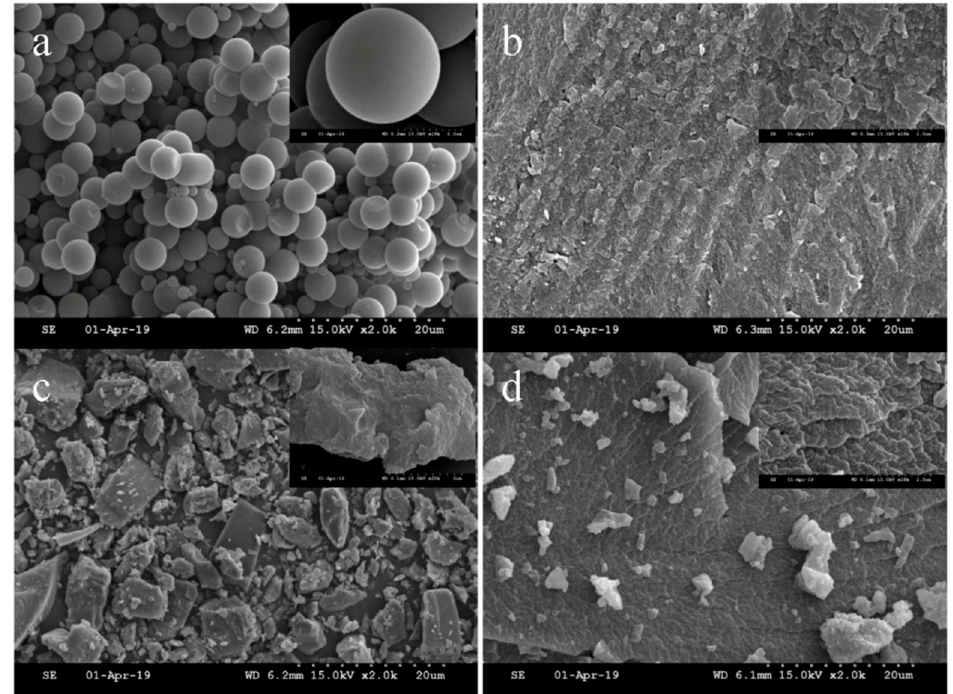
Figure 4. Field emission scanning electron microscopy (FE-SEM) images of ( a ) MIR, ( b ) DES 1 -MIR, ( c ) DES 2 -MIR and ( d ) DES 3 -MIR (magnification: 2.0k × and (inset) 18k × ).